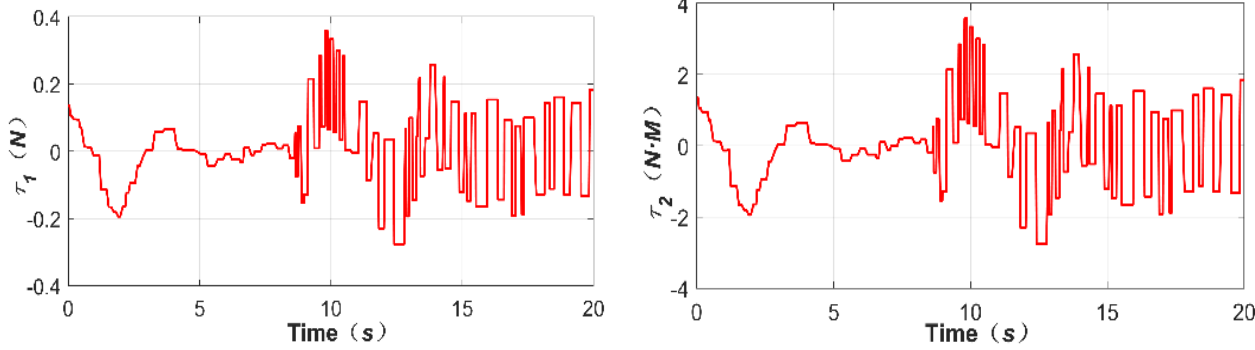
Figure 8. The simulation experiment control law ( τ 1 and τ 2